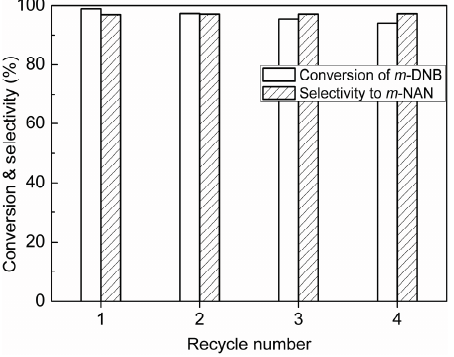
/Al O -2% in the hydrogenation of m x 2 3